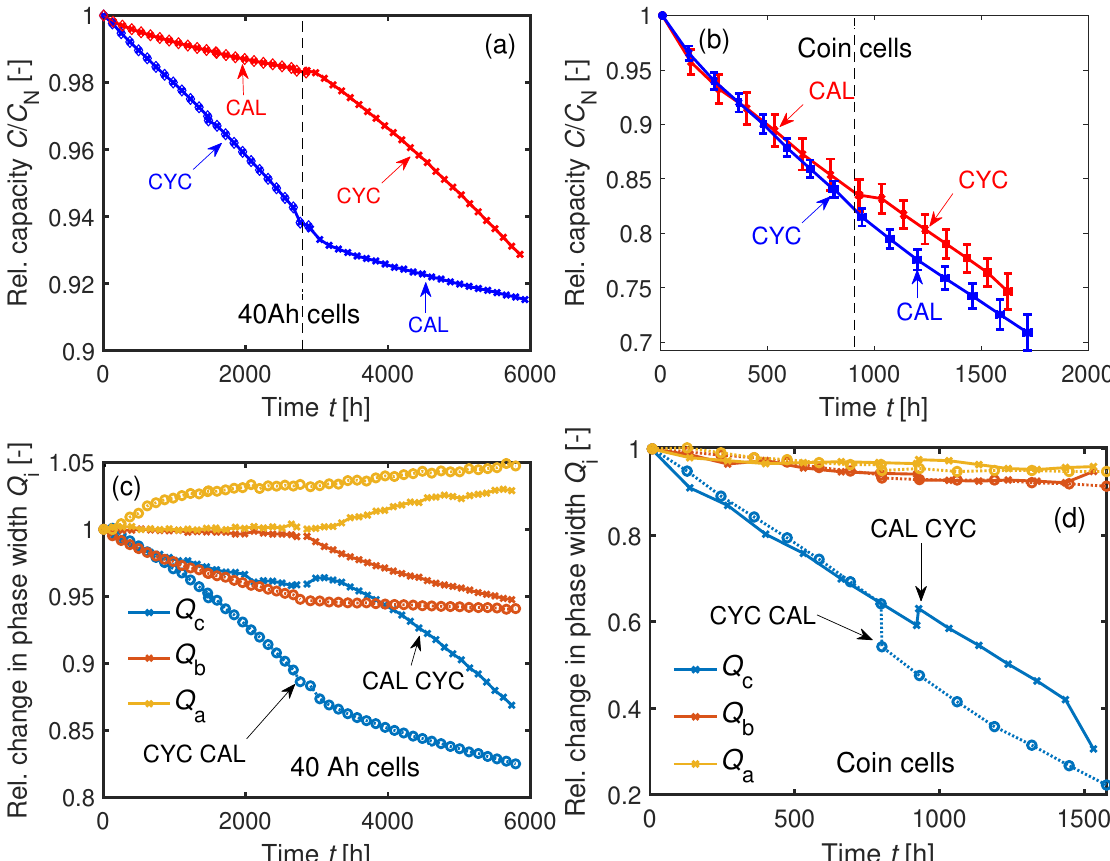
Figure 17. ( a ) Aging of two 40Ah cells at T = 35 ◦ C. One cell was calendrically aged before cyclic aging and vice versa. ( b ) Sequentially conducted cyclic and calendar aging (CYC CAL) and vice versa (CAL CYC) of four averaged coin cells at T = 35 ◦ C. ( c ) Changes in the phase widths of the two 40Ah cells. ( d ) Changes in the phase widths of the averaged coin cells. Temporary increase of Q c after calendar